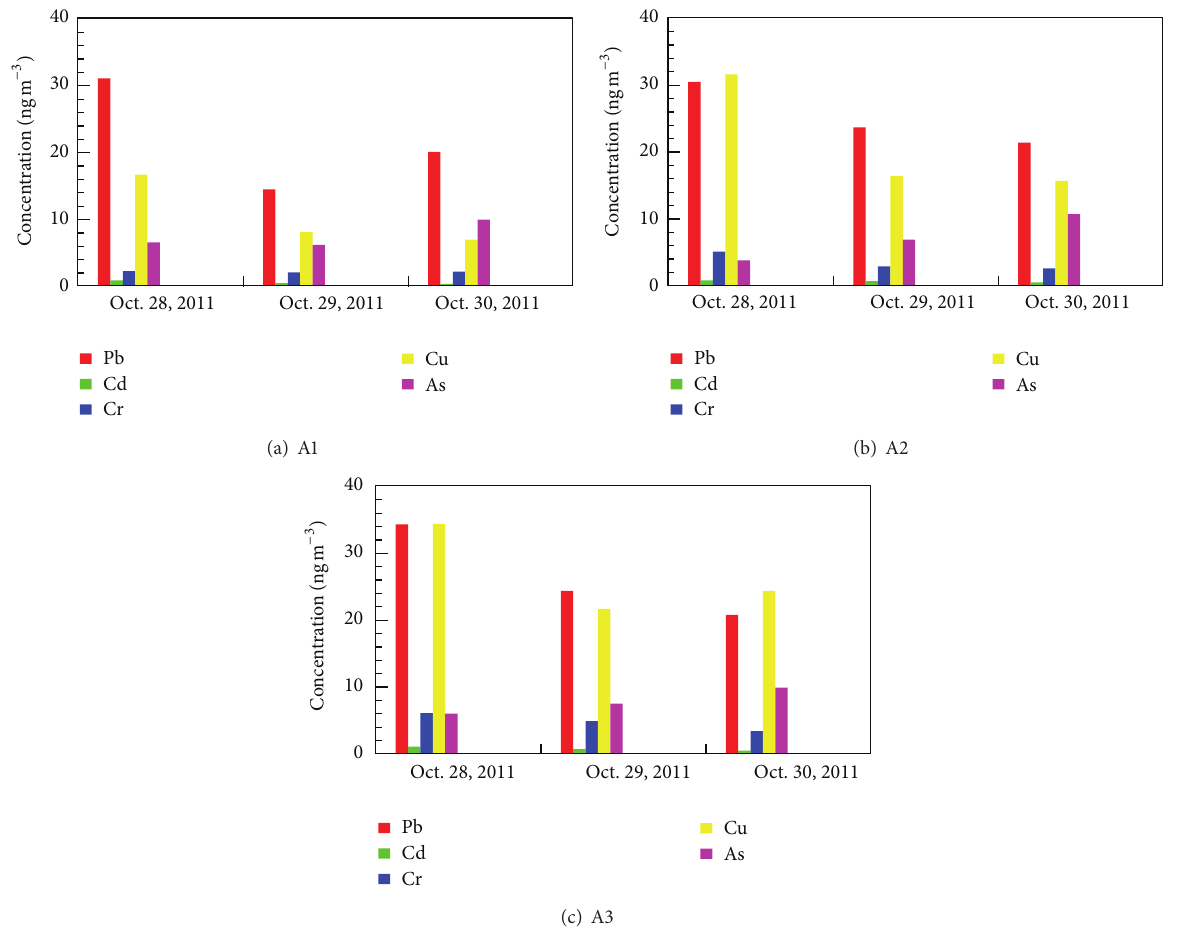
Figure 2: Concentrations of metals during the Busan Fireworks Festival event (Oct. 29) in 2011, measured at three monitoring sites (A1–A3).